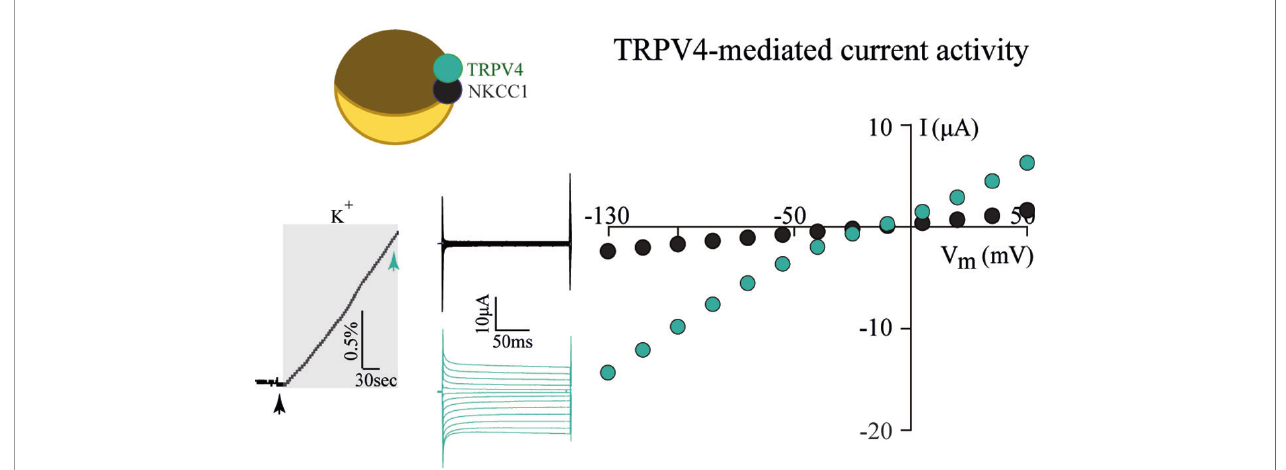
FIGURE 3 | TRPV4 is activated by cell swelling, independently of AQPs and osmotic gradients. The water-transporting cotransporter NKCC1, co-expressed with TRPV4 in Xenopus oocytes, was activated by exposure to K + (15 mM, equimolar replacement of Na + ). This transporter activation led to a rapid volume increase (left panel) in the absence of an external introduction of an osmotic gradient. This cell volume increase promoted TRPV4 activation in the form of TRPV4-mediated currents (middle and right panels). Modi fi ed from (32) with